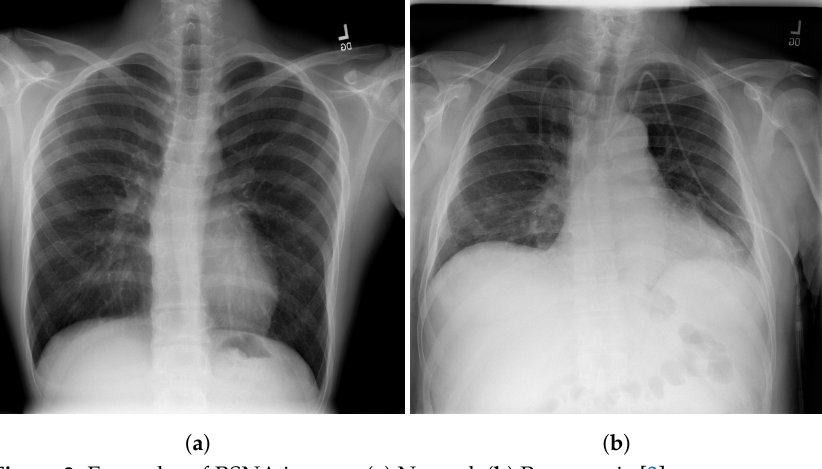
Figure 3. Examples of RSNA images: ( a ) Normal; ( b ) Pneumonia